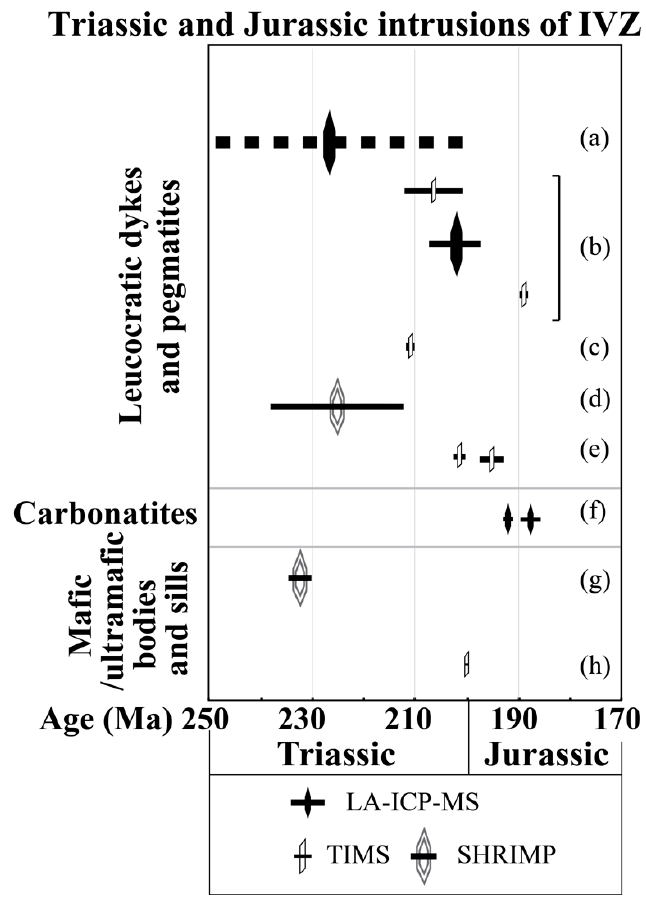
Figure 2. Schematic diagram showing U–Pb data from magmatic intrusions in the IVZ in the time span from Triassic to Jurassic. References: ( a ) [14]; ( b ) [22]; ( c ) [64]; ( d ) [20]; ( e ) [62]; ( f ) [59]; ( g ) [60]; (h) [57].